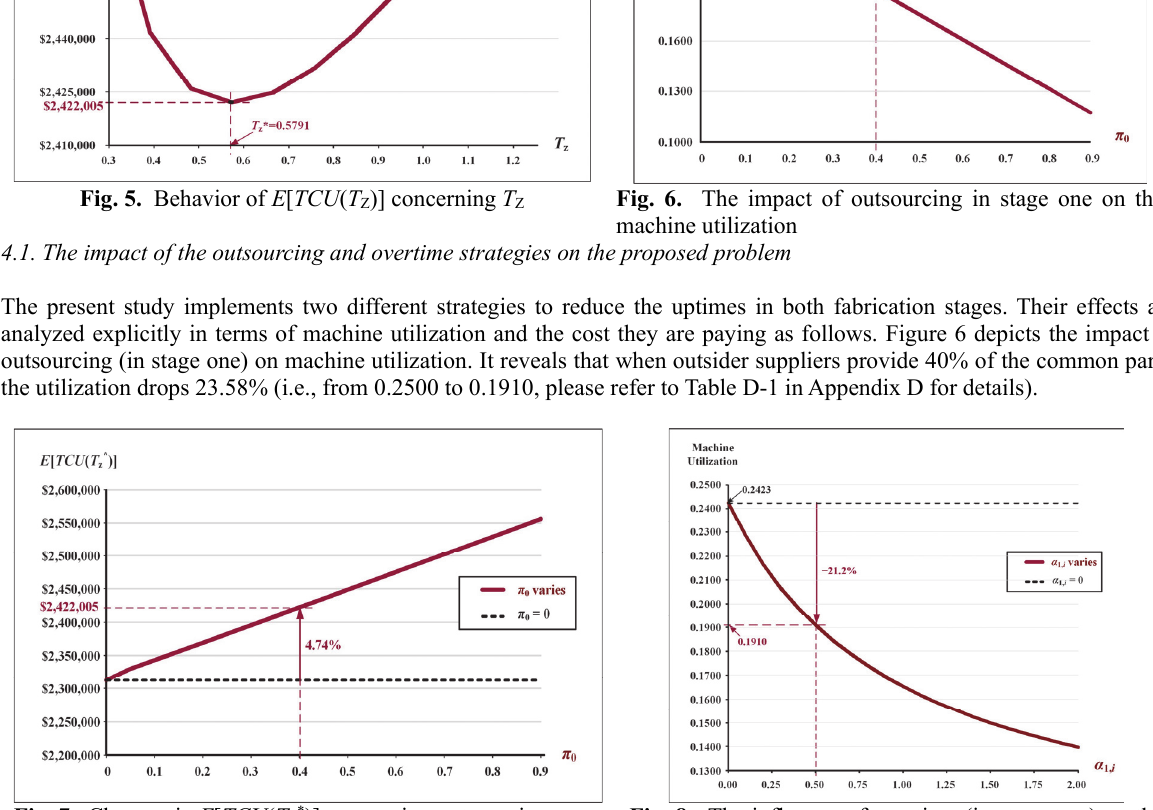
Fig. 7. Changes in E [ TCU ( T Z* )] concerning outsourcing percentage